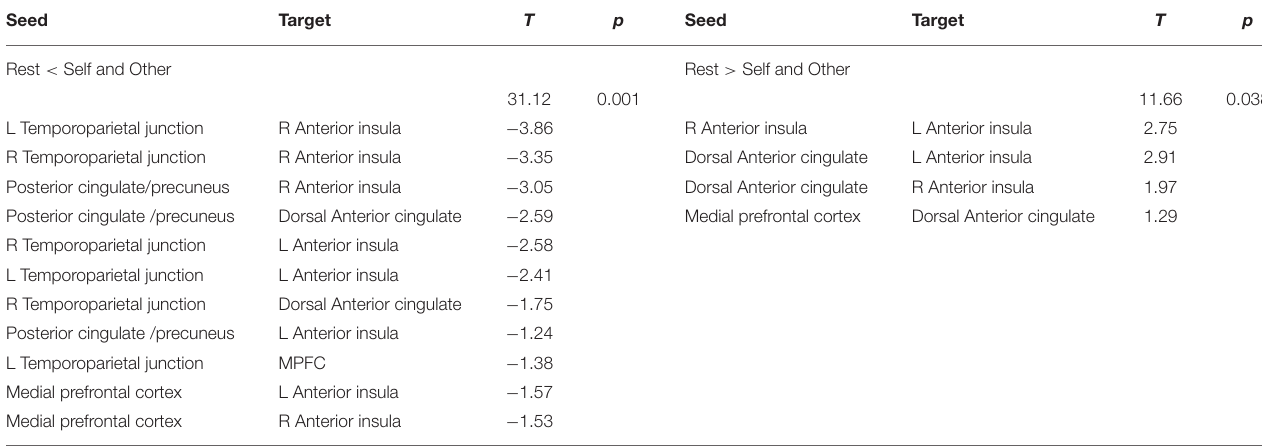
TABLE 4 | ROI-to-ROI results showing functional connectivity differences between the Rest and the Self and Other